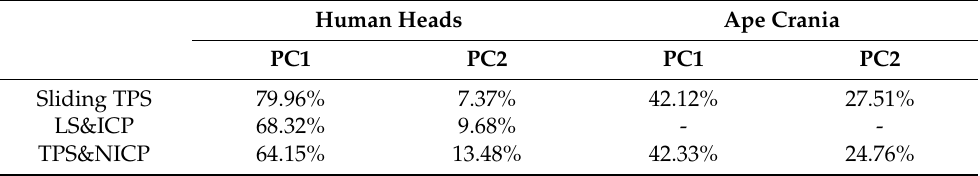
Figure 10. Superimposed scatterplots of PC 1 and PC 2 of mean shape surfaces using sliding TPS (red points), LS&ICP (green points), and TPS&NICP (cyan points) approaches. ( a ) Human heads. ( b ) Ape crania. Table 3. Percentages of total variance explained by PC 1 and PC 2 of the mean surface